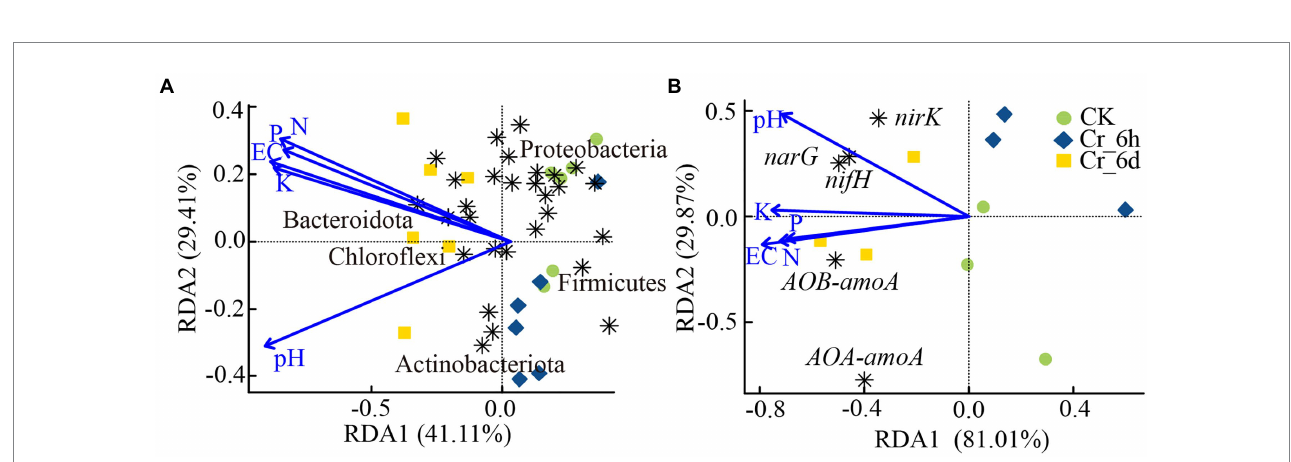
FIGURE 6 Relationship between soil physicochemical parameters and bacterial communities (A) and nitrogen cycle functional genes (B) revealed by redundancy analysis. The horizontal and vertical coordinates in the Figure indicate the degree to which the soil environmental factors explain the bacterial community structure (A) or phenotype (B) . The arrow in the Figure indicates the environmental factor, and the length of the line indicates the degree of correlation between the environmental factor and the bacterial community structure (A) or phenotype (B) . The longer the line, the greater the correlation, and vice versa. The angle between the line of the arrow and the axis indicates the correlation; the smaller the angle, the higher the correlation. An acute angle indicates a positive correlation, and an obtuse angle indicates a negative